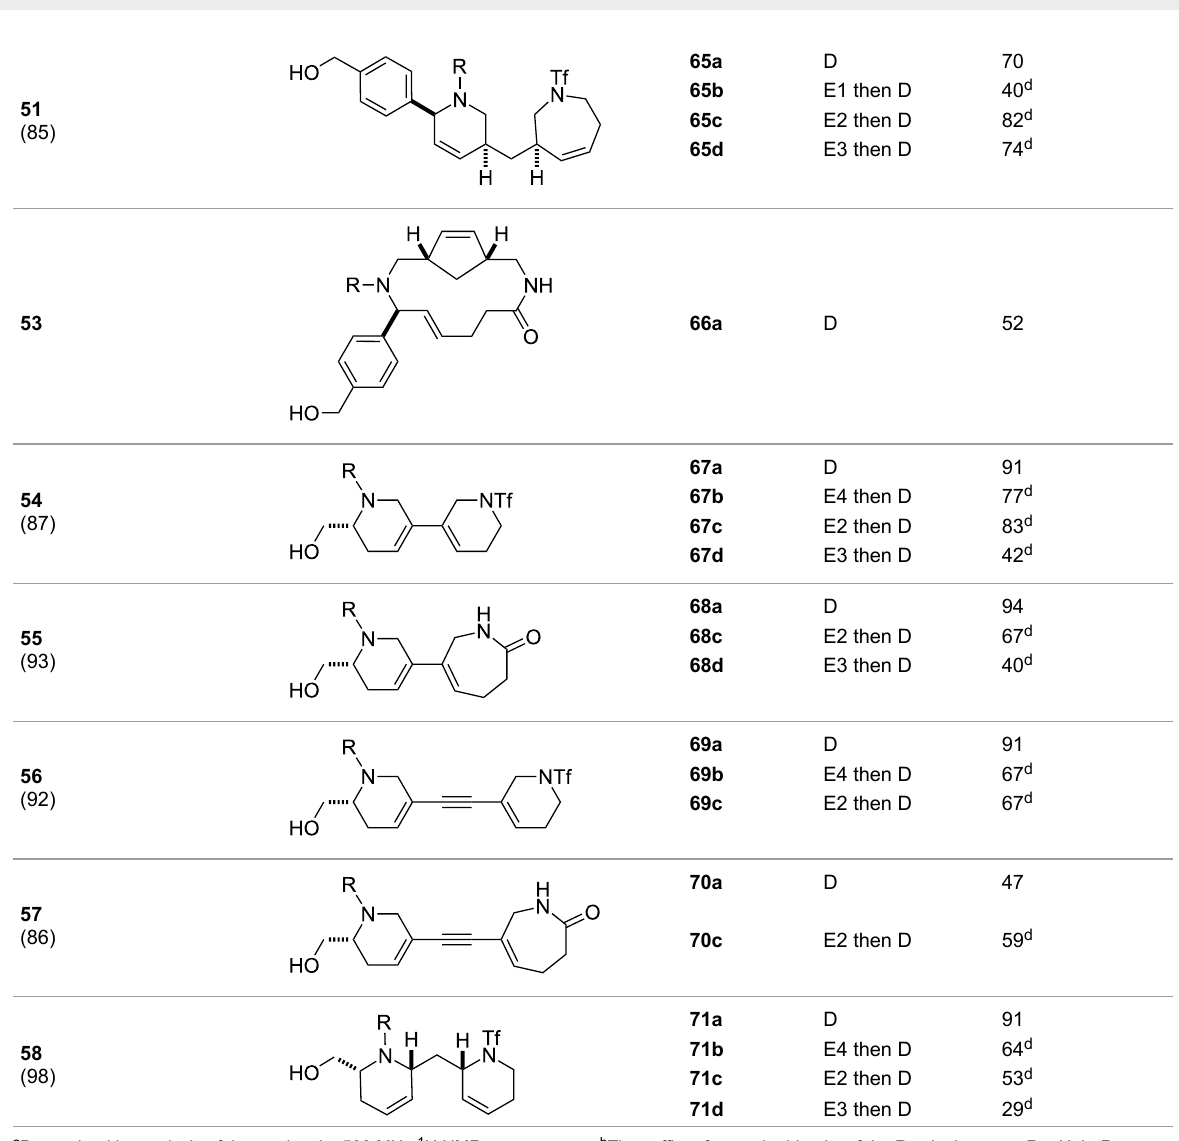
Table 4: Derivatisation and deprotection of final products.